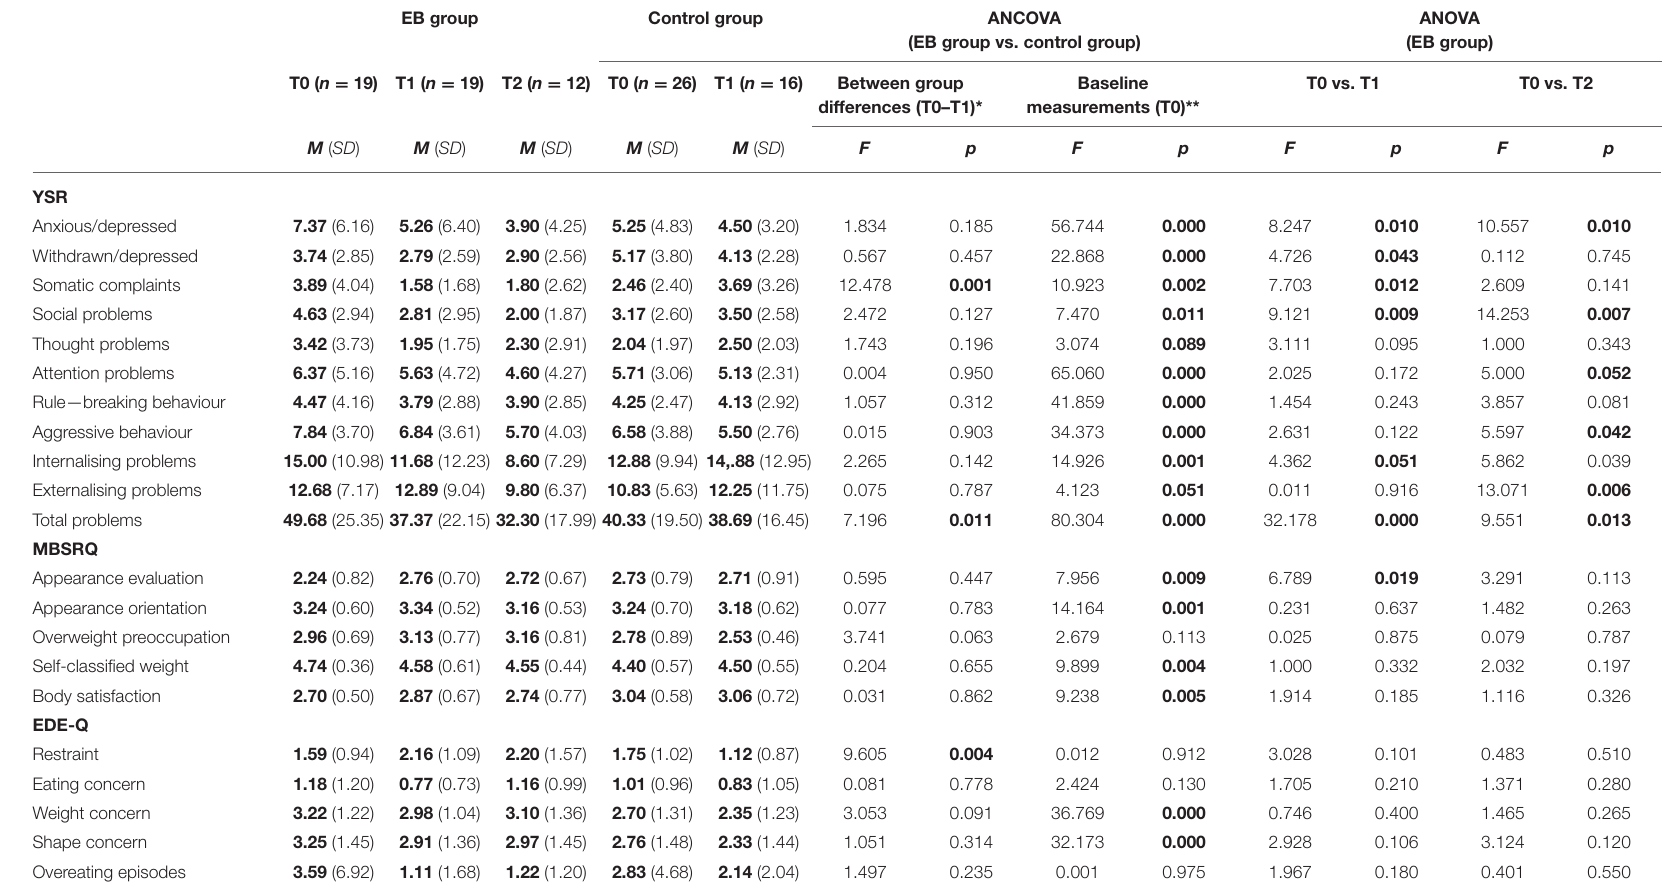
TABLE 2 | Measure outcomes at baseline (T0), after 12 months (T1), and 12 months after the device removal (T2); and between group and within group differences for psychological variables. EB group Control group ANCOVA